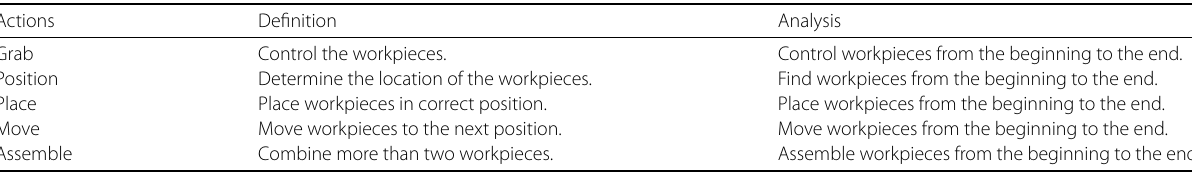
Table 1 Partial actions description of industrial